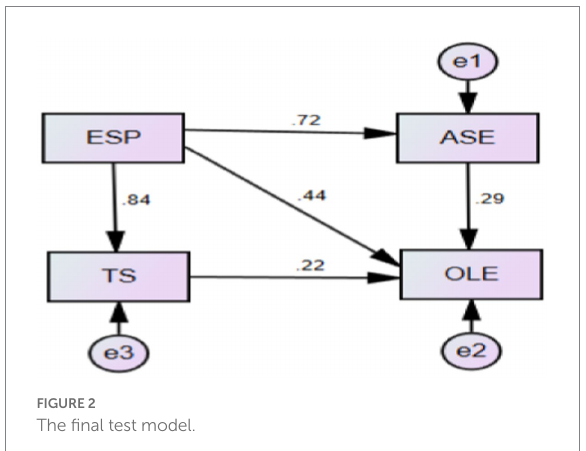
FIGURE 2 The final test